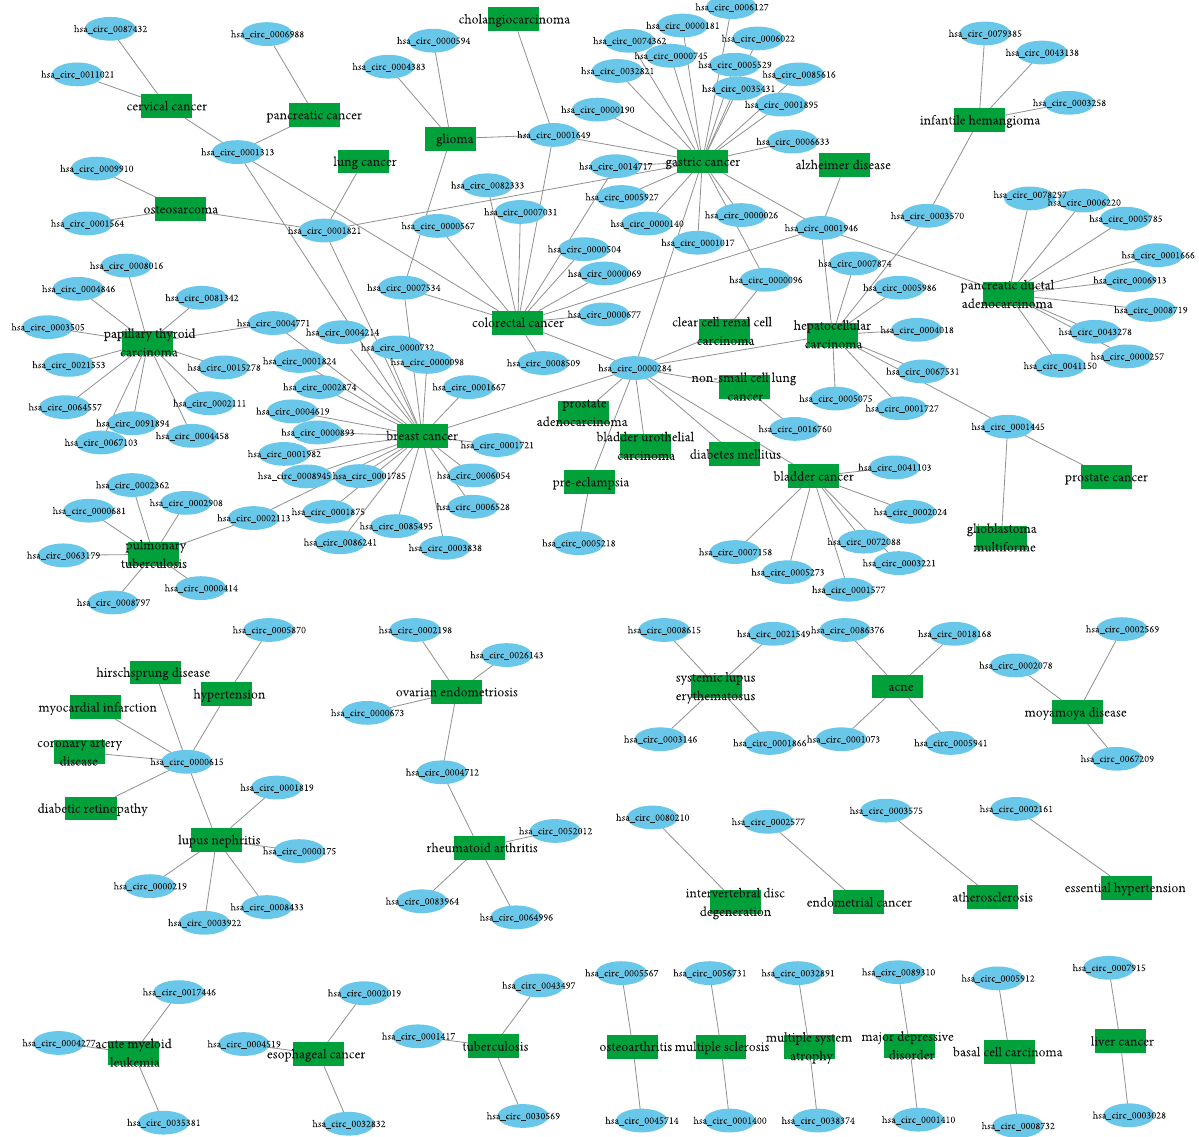
Figure 2: The bipartite graph of circRNA-disease